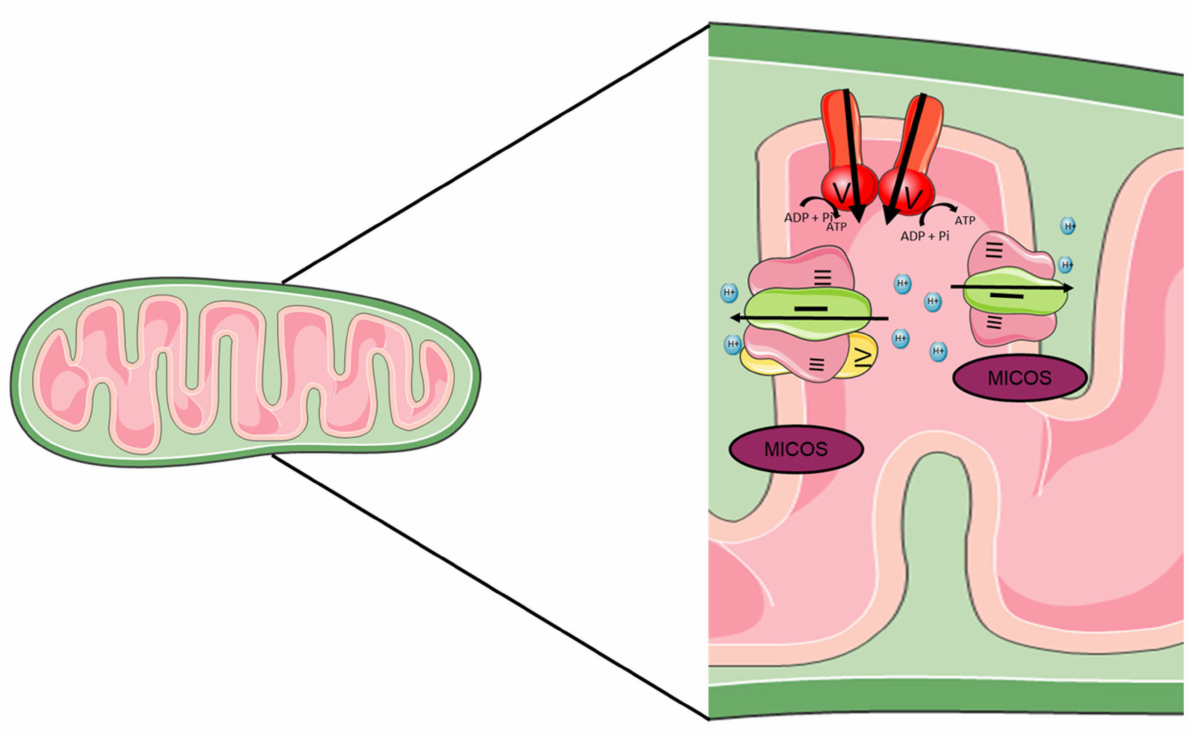
Figure 3. Structure of mitochondrial supercomplexes. The structure of the mitochondrial ridges is very important in the function of mitochondria and in particular in the stability of the super complex. Several proteins are involved in the stability of these ridges, the ATP synthase which will be at the top and the mitochondrial contact site and cristae organizing system (MICOS) which will be at the bottom. Between the two will be the super complexes. The two main super-complexes found in mammals I + III2 + IV1–4 and I + III2 are